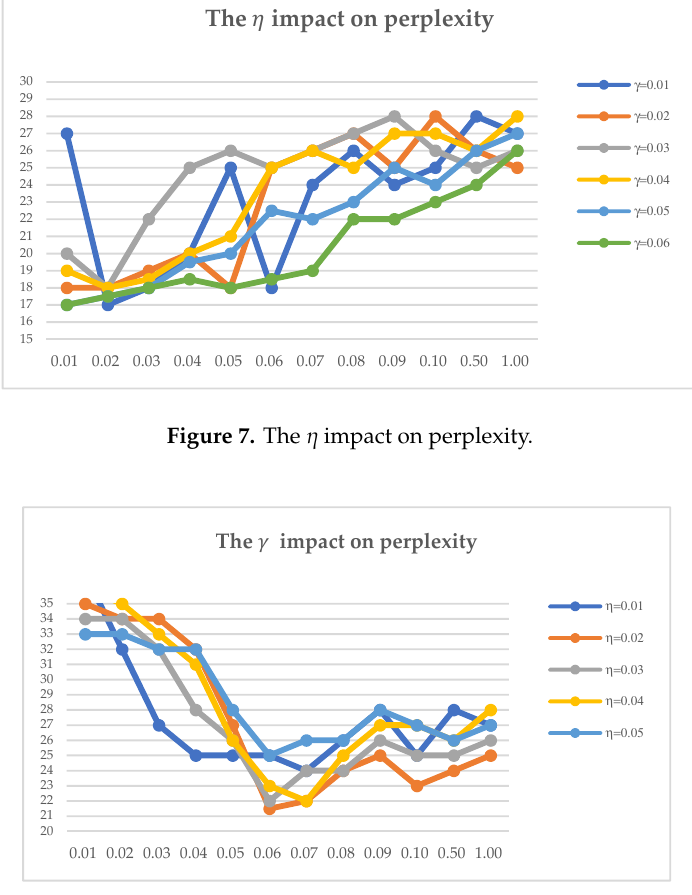
Figure 8. The 𝛾 impact on perplexity. Figure 8. The γ impact on